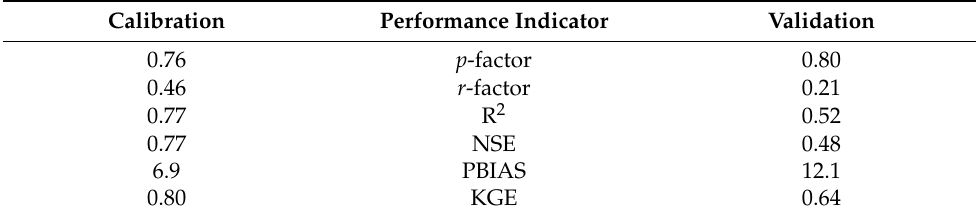
Table 6. Model performance indicators for the calibration and validation periods of the Nuˇcice SWAT model.